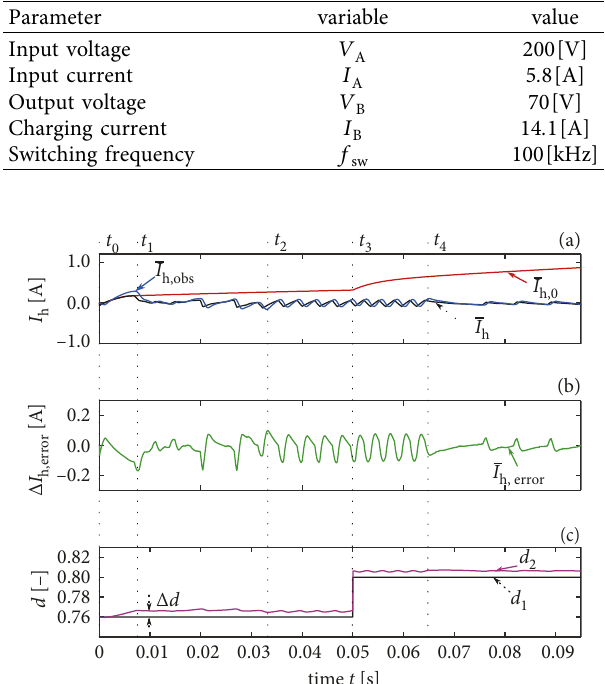
Table 5: Operating point for simulation and PSFB prototype at d, red for the two